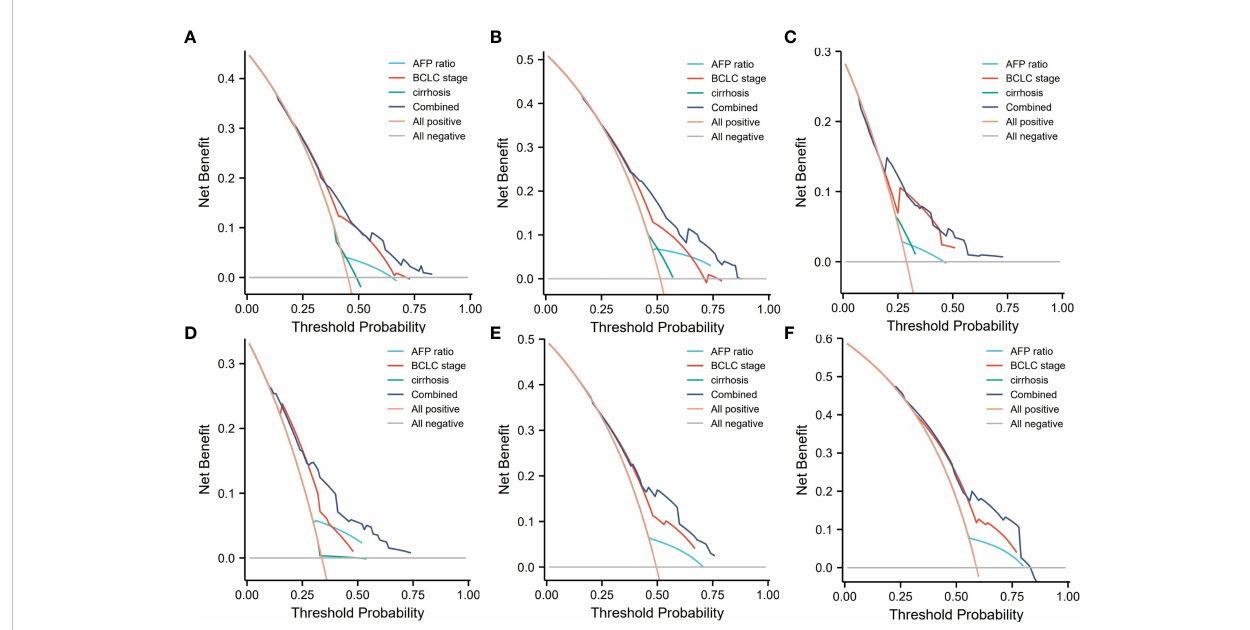
FIGURE 5 Decision curve analysis (DCA) of the nomogram. (A – C) DCA of 1-, 3-, and 5-year RFS predicted nomograms in the training cohort; (D – F) DCA of the 1-, 3-, and 5-year RFS predicted nomograms in the validation cohort. AFP ratio, alpha-fetoprotein ratio; BCLC, the Barcelona Clinic Liver Cancer staging